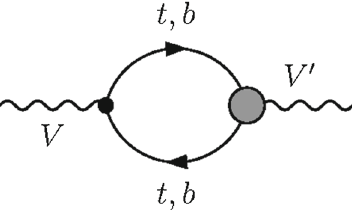
Fig. 8 Representative Feynman diagram contributing to the S , T , U parameters at one-loop. The grey-shaded area marks a possible dimen- sion six insertion while the black dot represents a SM vertex of the V − V (cid:15) polarisation function, V , V (cid:15) = W ± , Z ,γ